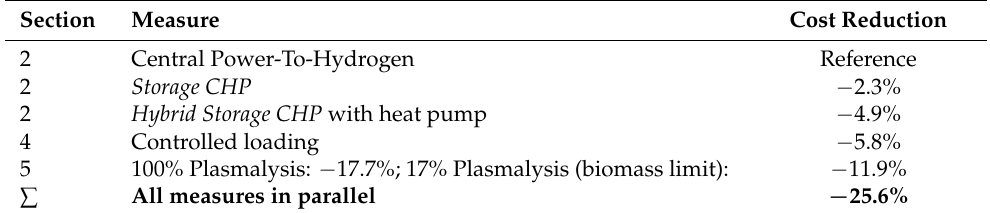
Table 2. Overview of cost reductions across all Sections. The total reduction (25.6%) is slightly larger than the arithmetic sum of all single effects